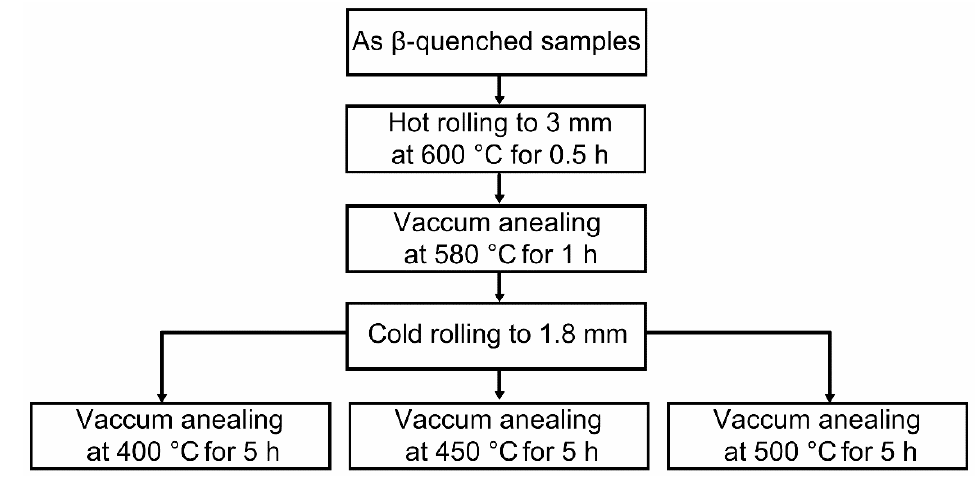
Figure 1. Processing flow of the experimental Zr alloy.